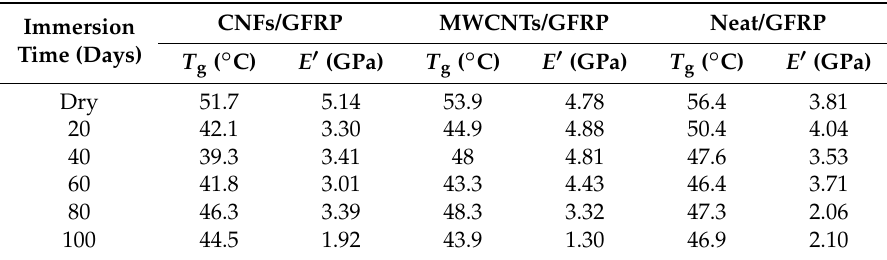
Table 2. Storage modulus ( E (cid:48) ) and glass transition temperature ( T g ) of Neat/GFRP, CNFs/GFRP, and MWCNTs/GFRP coupons immersed at temperature 45 ◦